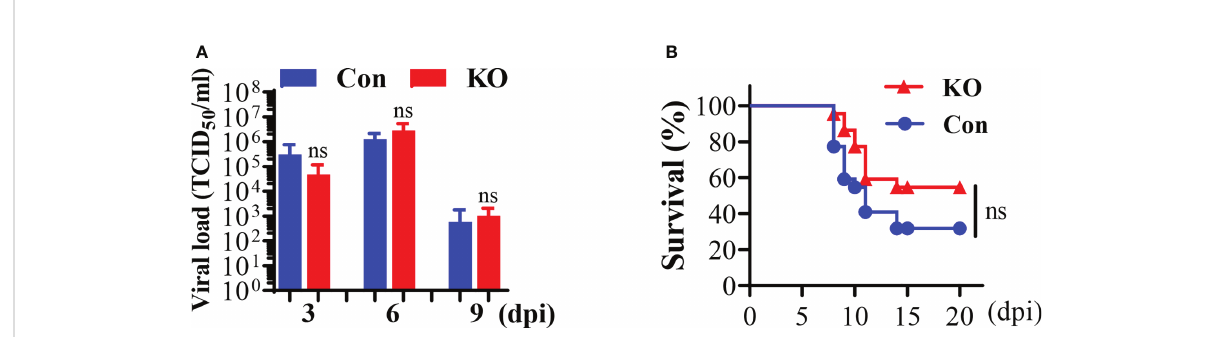
FIGURE 3 A general Runx3 KO in adult mice has a minor effect on viral clearance and mortality by IAV infection. (A) KO of Runx3 has a minor effect on IAV viral clearance. Sex- and age-matched littermate control (Con) and Runx3 KO (KO) mice were infected with 1 LD50 of H1N1 PR8 strain. BALFs were subjected to infectious virus titer assay in MDCK cell and presented as TCID 50 /ml (n=5-6). (B) KO of Runx3 has no signi fi cant effect on the mortality by IAV infection. Sex-and age-matched control (n=22) and Runx3 KO (n=22) mice were infected with 1.35 LD50 of H1N1 PR8 strain and animal survival was assessed over a period of 20 days pi. Animals were monitored until death. Two control mice and one KO mouse had weight loss of more than 30%, at which point they were euthanized and counted as dead. Student ’ s t test was performed in (A) and Log-rank (Mantel-Cox) test was performed in (B) . NS, no signi fi